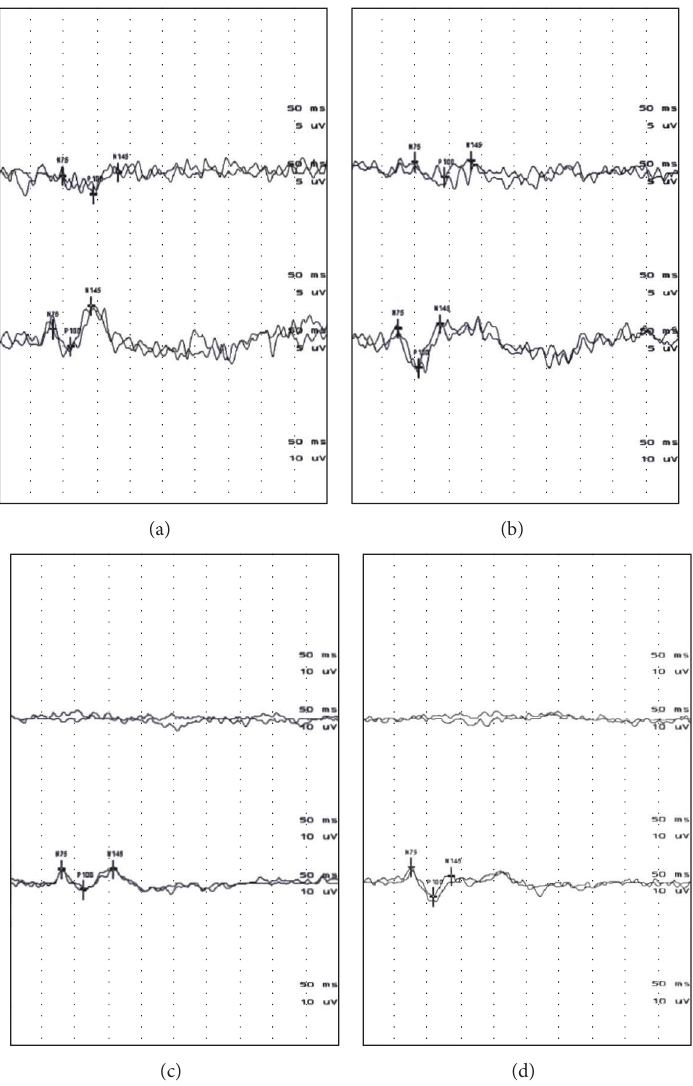
Figure 2: Visual evoked potentials (VEPs) at onset ((a), (b)) and at two months follow-up ((c), (d)). (a)-(b): Response at 15 (a) and 30 (b) sec showing destructured response, reduced amplitude and prolonged latency on the left and normal response on the right side. (c)-(d): Response at 15 (c) and 30 (d) sec revealing absent response on the left and destructured response with normal amplitude and latency on the right